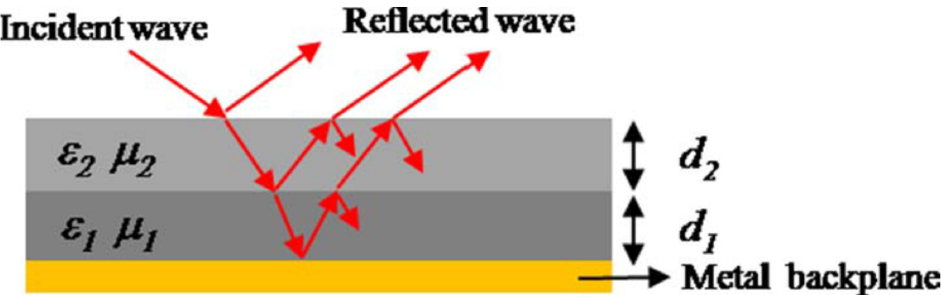
Figure 10. Schematic of laminated electromagnetic wave absorption materials [53]. Reproduced with permission from Elsevier.